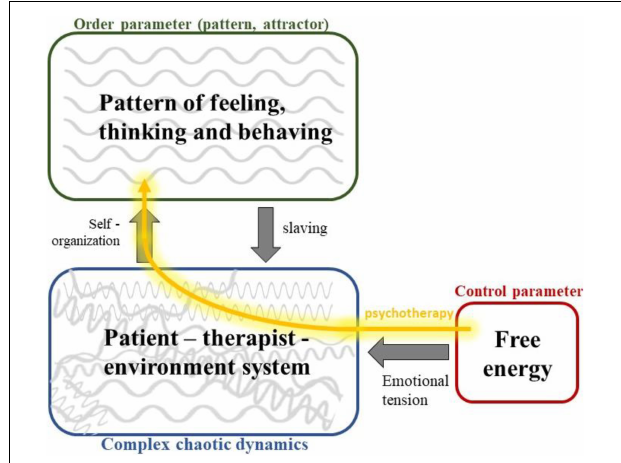
FIGURE 1 | Synergetics applied to psychological change. When Free energy (i.e., uncertainty/prediction errors) reaches a critical level, the usual pattern of feeling, thinking, and behaving can no longer coordinate and synchronise system dynamics. These patterns, which in FEP terms correspond to a shared generative model (see Section “Merging Predictions in the Pre-subjective Chaos”), can be disturbed and altered by critically increasing energetic tensions, so that the organism or system of organisms self-organises into a novel metastable order parameter. Change occurs (either in the direction of healthy or psychopathological development) at this point of bifurcation, when the update of the order parameters prevails over the slaving of the complex dynamics. This non-linear shift is promoted by psychotherapy, which renders it possible to introduce into the system uncertainty, novelty and the necessary distance to assimilate surprise without reproducing and re-enacting previously acquired behavioural